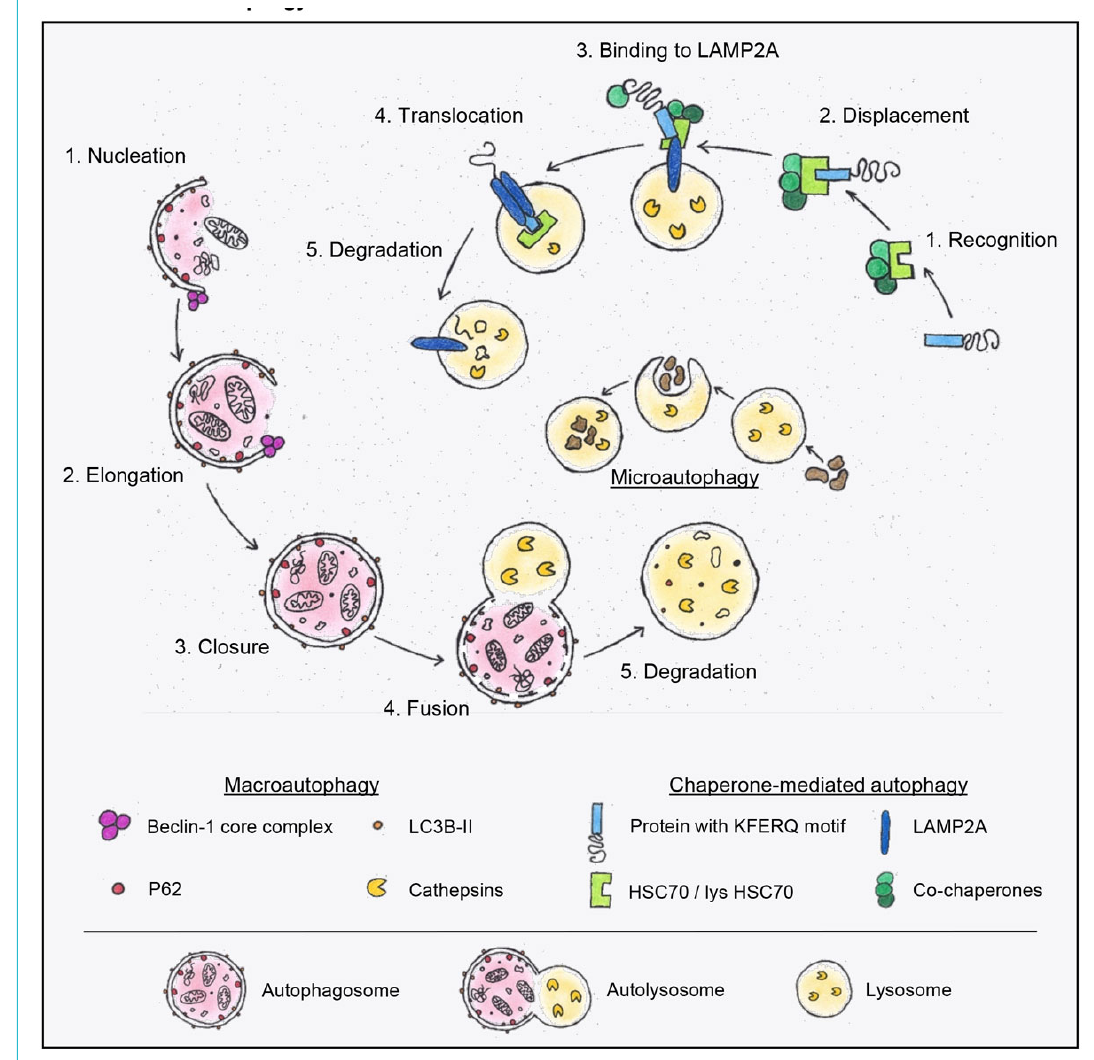
Figure 1: Schematic presentation of macroautophagy, chaperone-mediated autophagy (CMA) and microautophagy. On the left hand side, an overview of macroautophagy is depicted in red. The isolation membrane forms during the nucleation process. An important player in nucleation and elongation is the Beclin-1 core complex. During the elongation of the double membrane LC3B is lipidated and allows the bind- ing of adaptor proteins such as p62. After autophagosome closure, the autophagosome fuses with the lysosome, followed by degradation and recycling of its contents. The degradation is mediated by cathepsins. These proteases become activated in the low pH found in lysosomes. In the middle of the diagram, microautophagy, a process characterised by the direct uptake of cytosolic material into the lysosome, is depicted. On the right, the chaperone mediated autophagy (CMA) pathway is outlined. In this process, proteins containing a KFERQ amino acid se- quence motif are recognised by a chaperone complex containing HSC70. The complex is then translocated to the lysosome and, with the help of the LAMP2A complex, incorporated into the lysosome and degraded.p62 = sequestosome 1, SQSTM1; LC3B = microtubule-associated pro- tein light chain 3B; HSC70 = heat shock 70 kDa protein 8; LAMP2A = lysosome-associated membrane protein